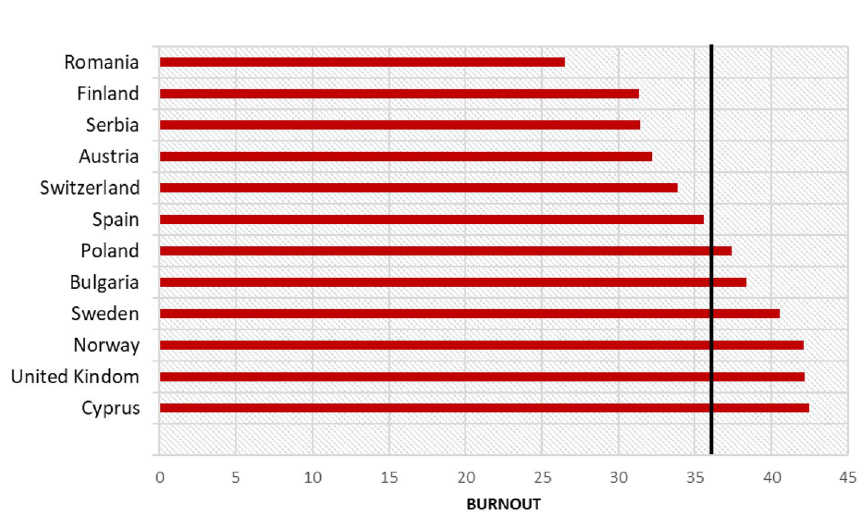
Figure 1. Burnout mean levels values per country. A black line indicates a grand